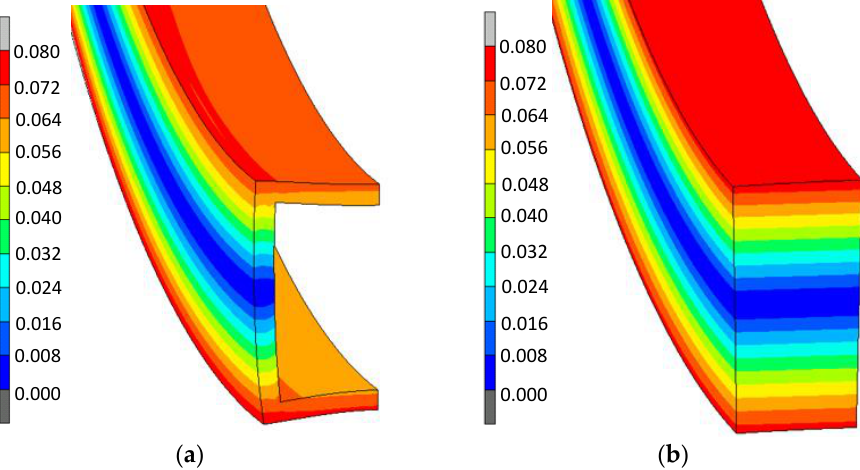
Figure 2. Distribution of equivalent strains on the cross-section of a tube with dimensions of 21.5 × 21.5 × 1.8 mm ( a ) and a bar with dimensions of 21.5 × 21.5 mm ( b ), bent on the radius of the value R = 0.147 m.